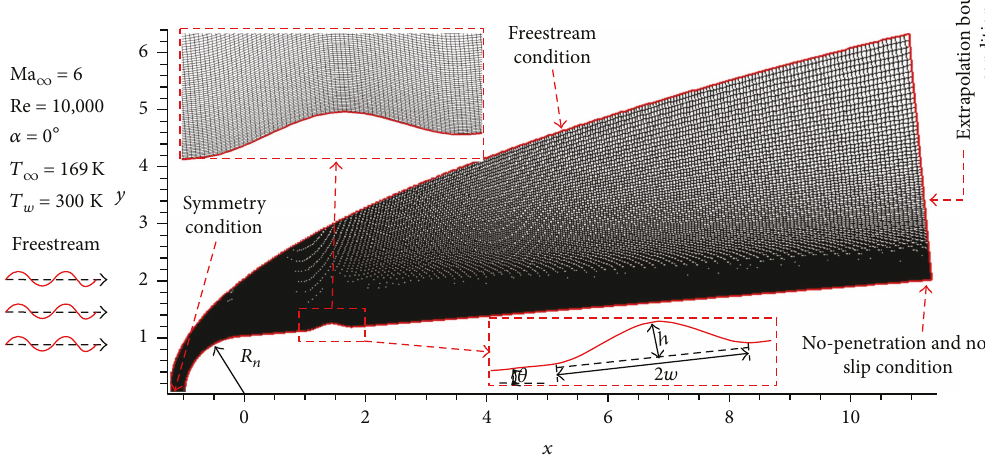
Figure 1: Calculational model and grid Table 1: The condition of roughness.